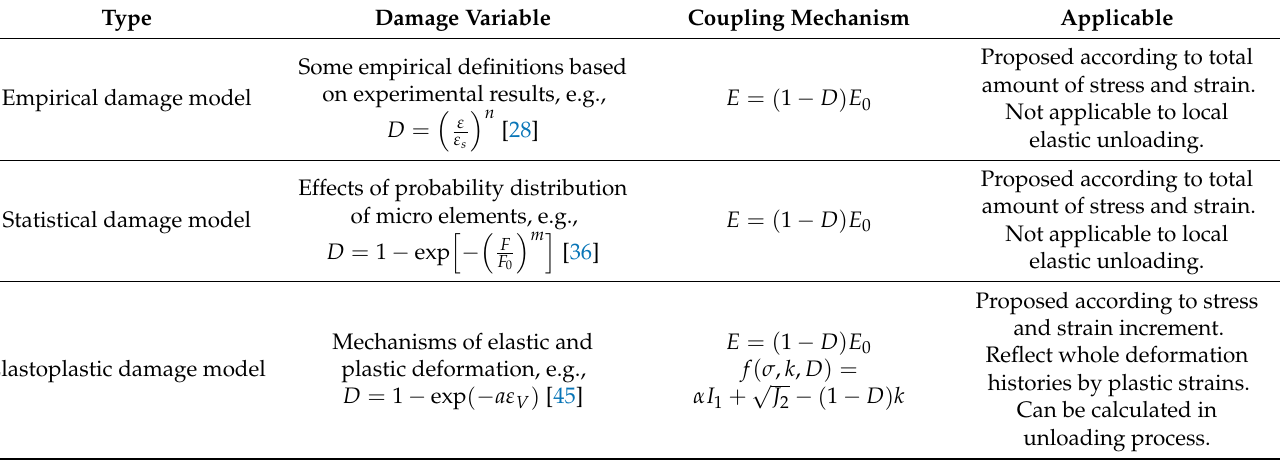
Table 1. The summary of calculated